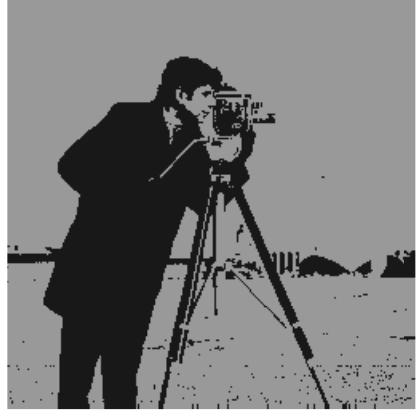
Figure 27. Cameraman using GMM.